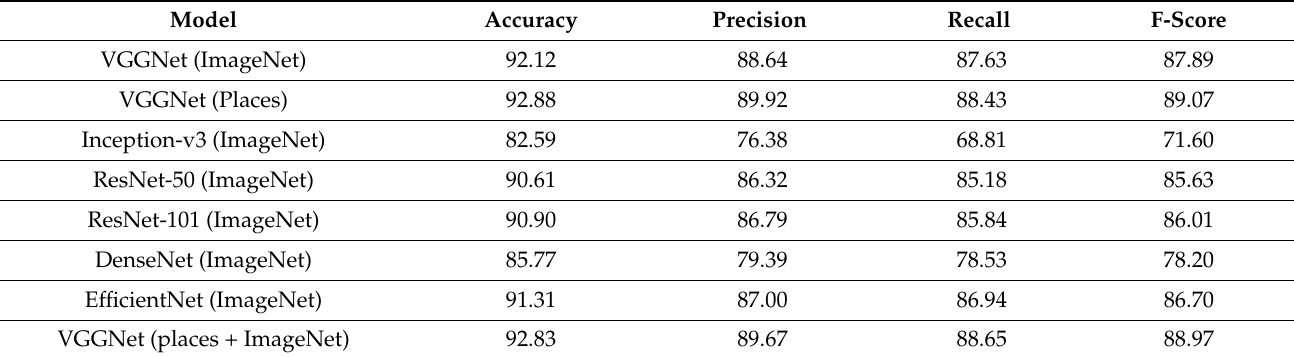
Table 6. Evaluation of the proposed visual sentiment analyzer on task 1 (i.e., single-label classification of three classes, namely negative, neutral, and positive).